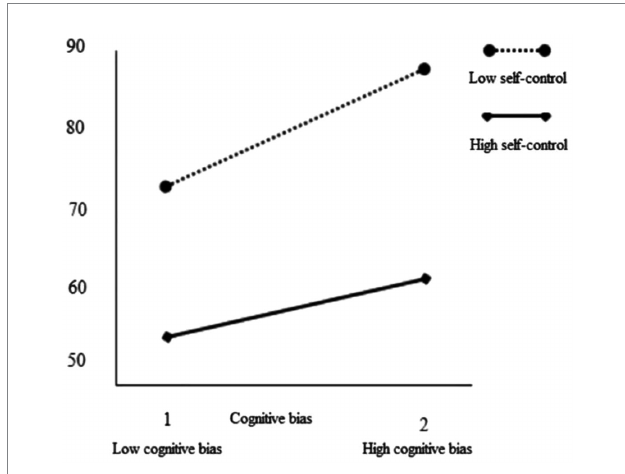
FIGURE 2 The moderating role of self-control between cognitive bias and trait